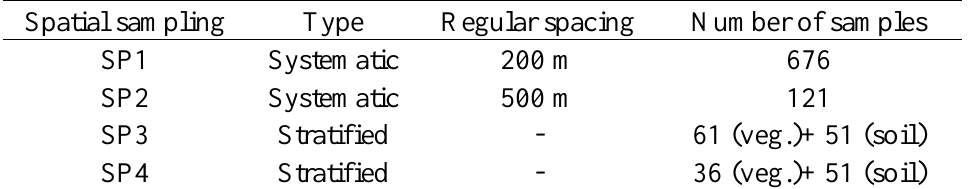
Table 4. Spatial sampling schemes derived from the LAI reference map.